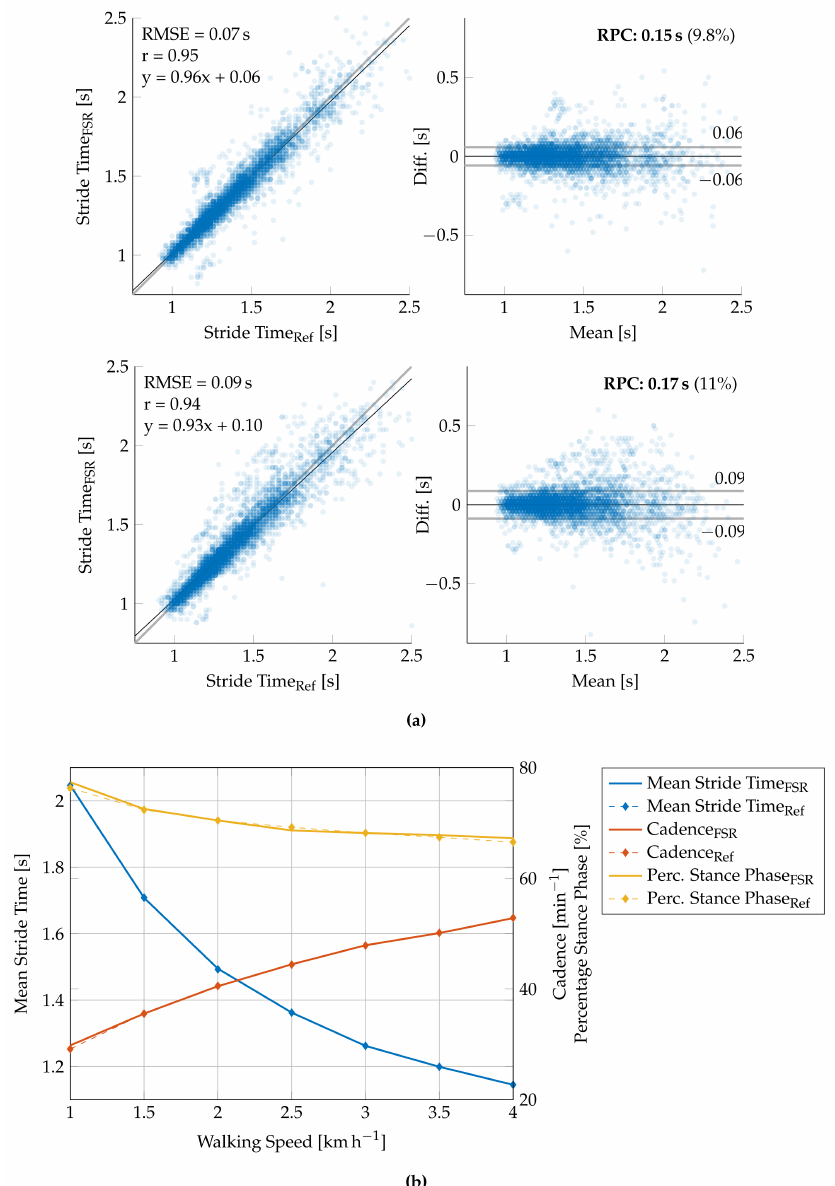
Figure 12. Validation results of the speed-related gait parameters. ( a ) Correlation ( left ) and Bland–Altman ( right ) plot for the HS-based stride time extraction ( above ) and the TO-based stride time extraction ( below ) for all strides detected during walking trials. ( b ) Graphical representation